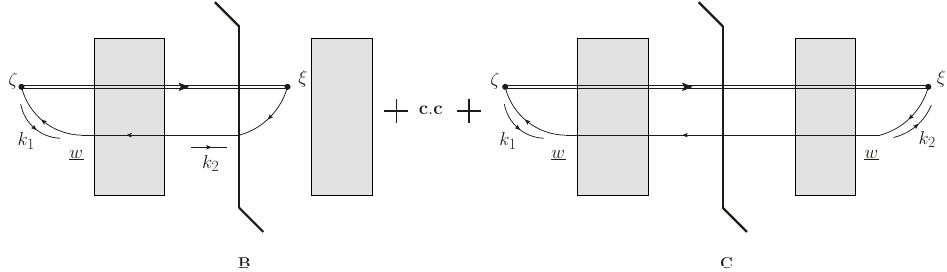
. In the diagram 2